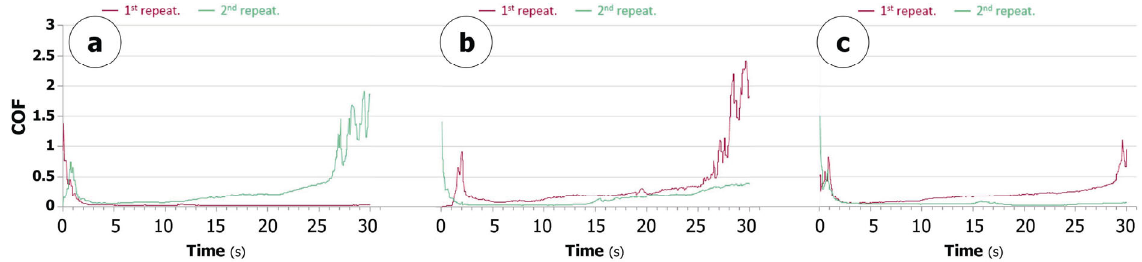
Fig. 11 Evolution of the COF during the polymer lubricated tribotests for the mirror-polished (a) tool steel A, (b) tool steel V, and (c) tool steel O pin samples (load 10 N, stroke length 4 mm, frequency 12.5 Hz, temp. 300